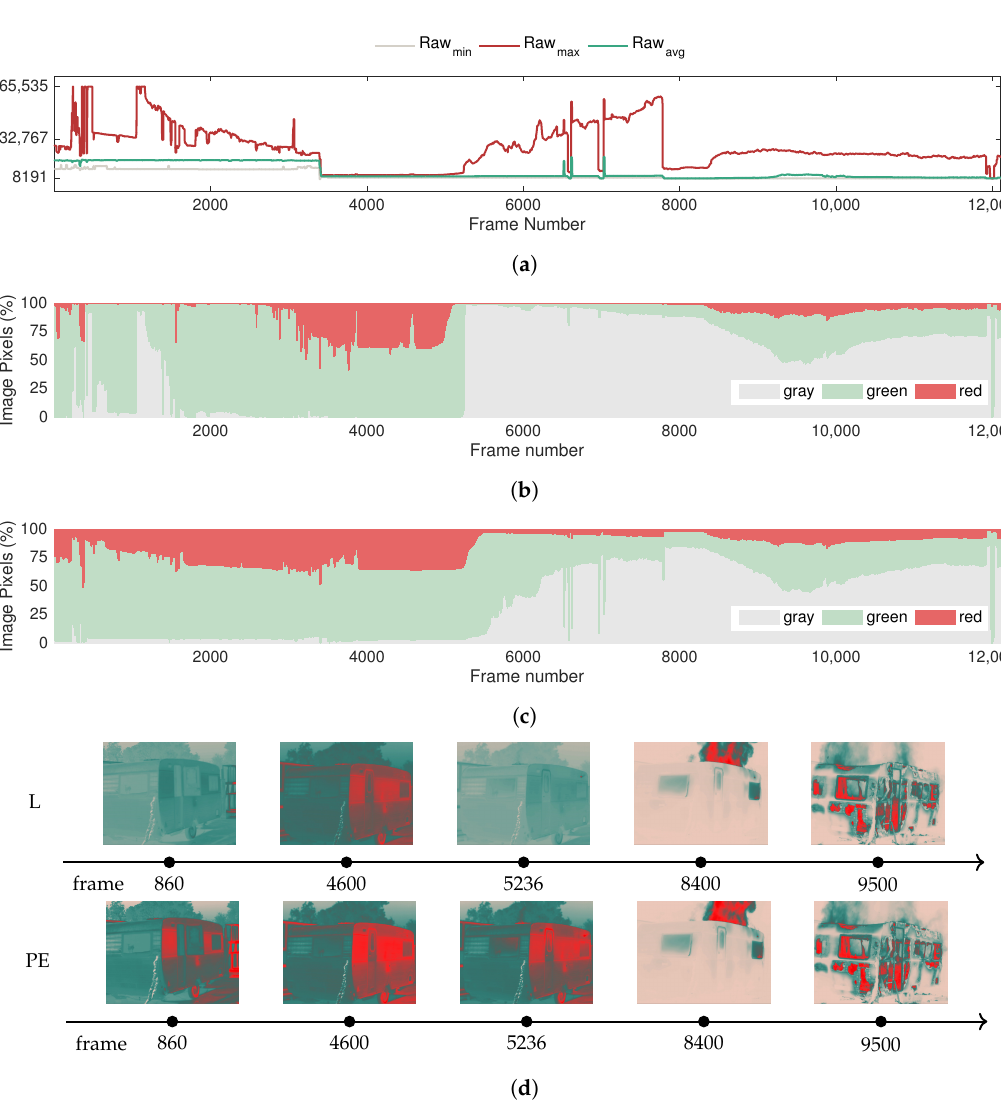
Figure 18. Representation of the filtered sensor response of the thermal camera to a fire ignition inside the caravan: ( a ) raw variables; ( b ) color-based features with the linear AGC (L); ( c ) color-based features with the plateau equalization AGC (PE); ( d ) comparison of frames between both